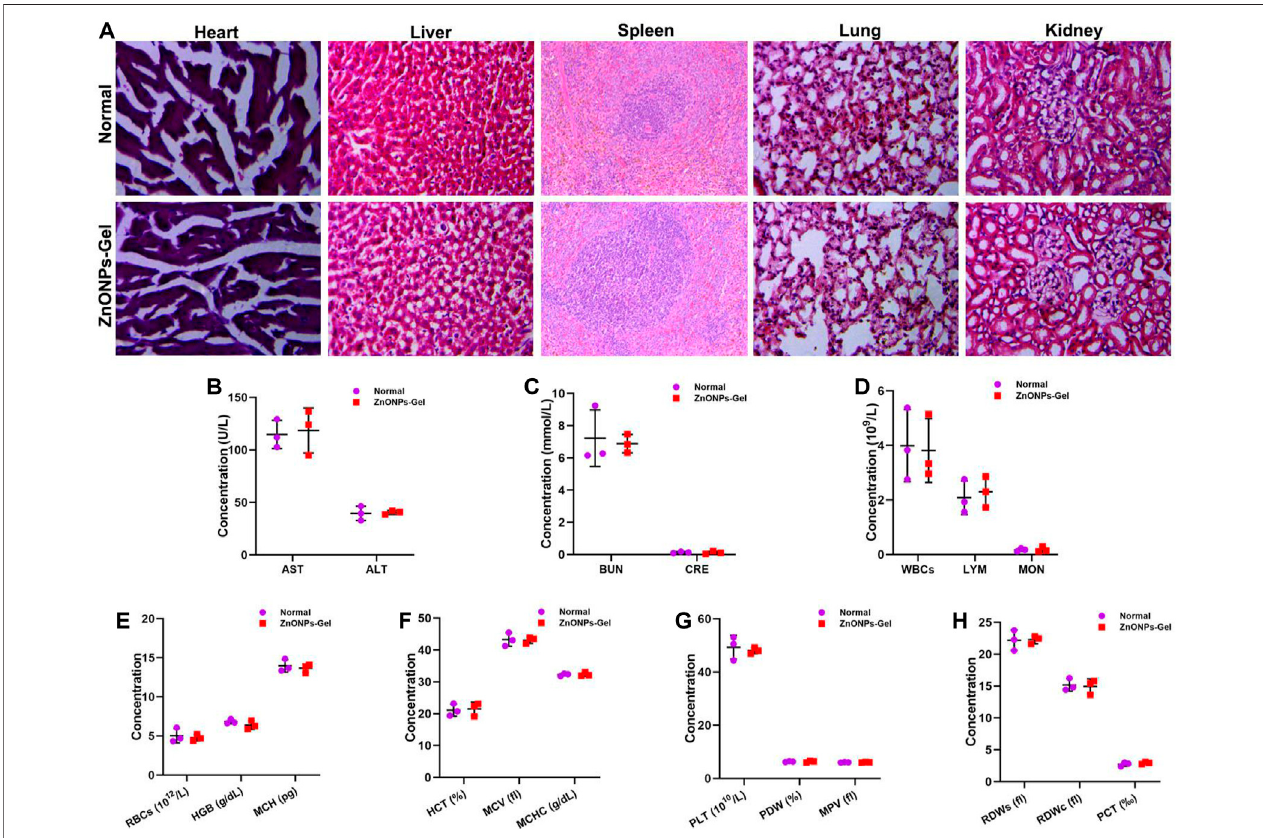
FIGURE 8 | Implantation of ZnONPs-Gel had biological safety in SCI mice. HE staining of heart, liver, spleen, lung, and kidney in normal mice and ZnONPs-Gel- implantedmice (A) .Representativequanti fi cationoftheAST (B) ,ALT (B) ,BUN (C) ,CRE (C) ,WBCs (D) ,LYM (D) ,MON (D) ,RBCs (E) ,HGB (E) ,MCH (E) ,HCT (F) ,MCV (F) , MCHC (F) , PLT (G) , PDW (G) , MPV (G) , RDWs (H) , RDWc (H) , and PCT (H) content in normal mice and ZnONPs-Gel implanted mice at 28 days after SCI. Data are mean ± SD ( n (cid:2)